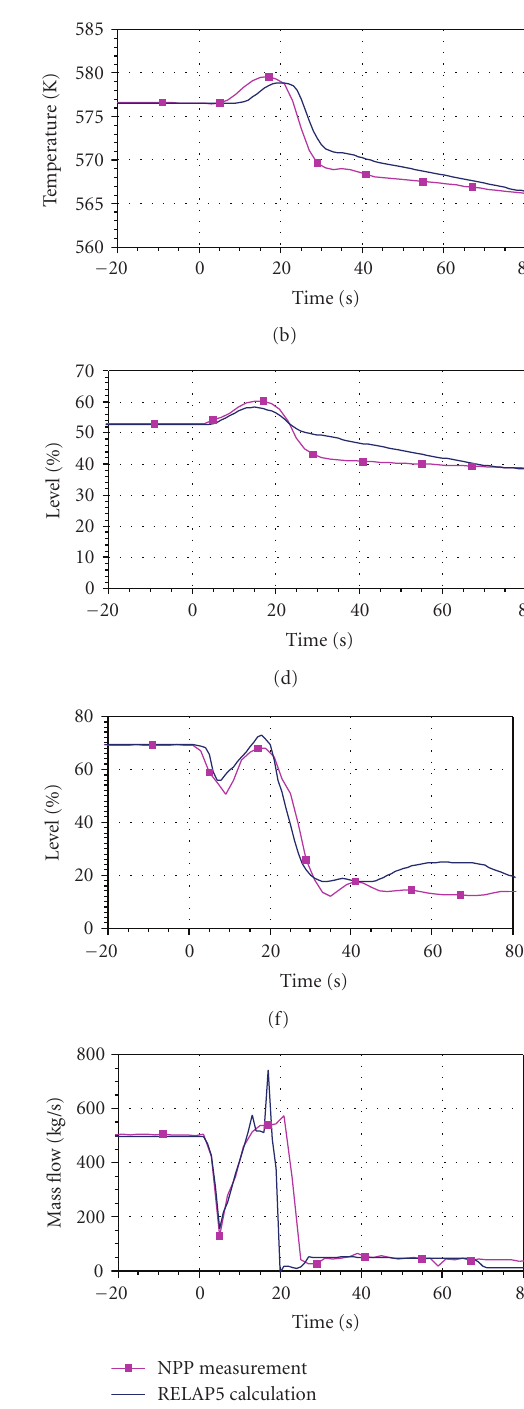
column the initial conditions at the time of transient start ( t = 0). When comparing the RELAP5 initial conditions with measured initials conditions, with the exception of feedwater flow for loop 2, all values are within design